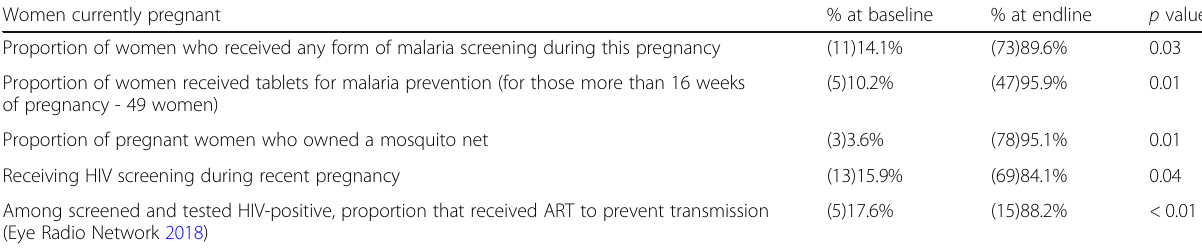
Table 2 Results of women who received essential infectious disease control services before and after project implementation Women currently pregnant % at baseline % at endline p